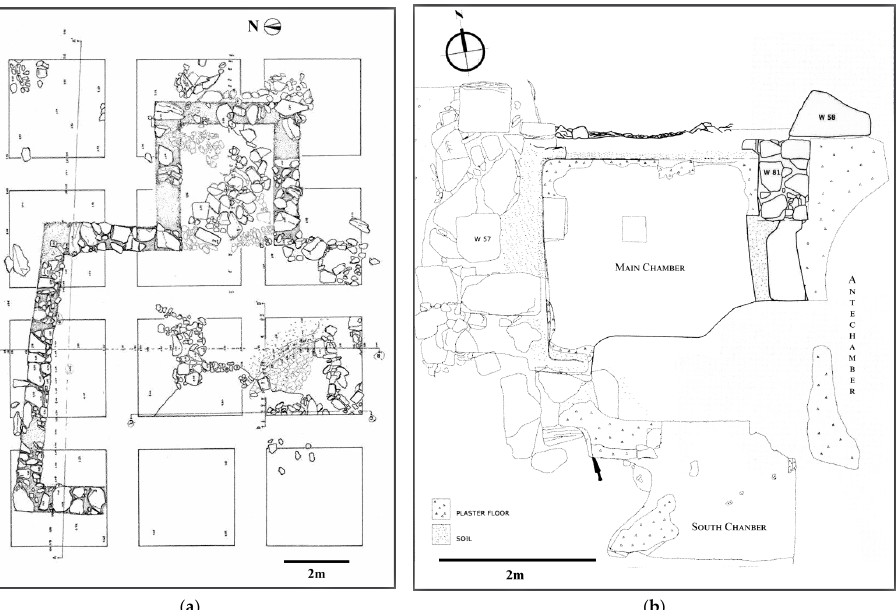
Figure 2. ( a ) Plan of the open-air sanctuary at Kophinas in South-Central Crete (image courtesy of the director of the 1990 Kophinas excavation, Dr. Alexandra Karetsou). ( b ) Plan of the Fetish Shrine uncovered by the excavations at Knossos Anetaki in North-Central Crete (image courtesy of the director of the Knossos Anetaki excavations, Dr. Athanasia Kanta).